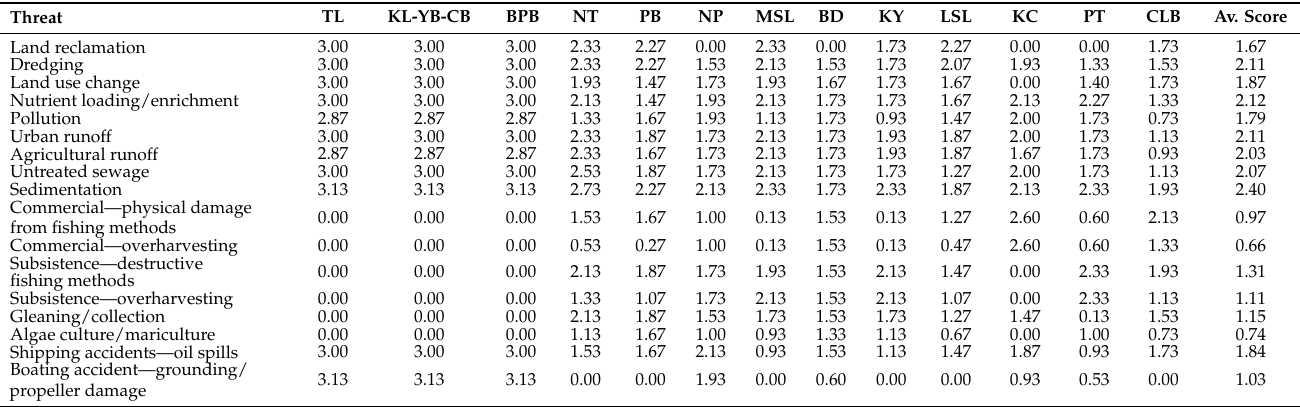
Table 3. Vulnerability scores for each threat at each seagrass